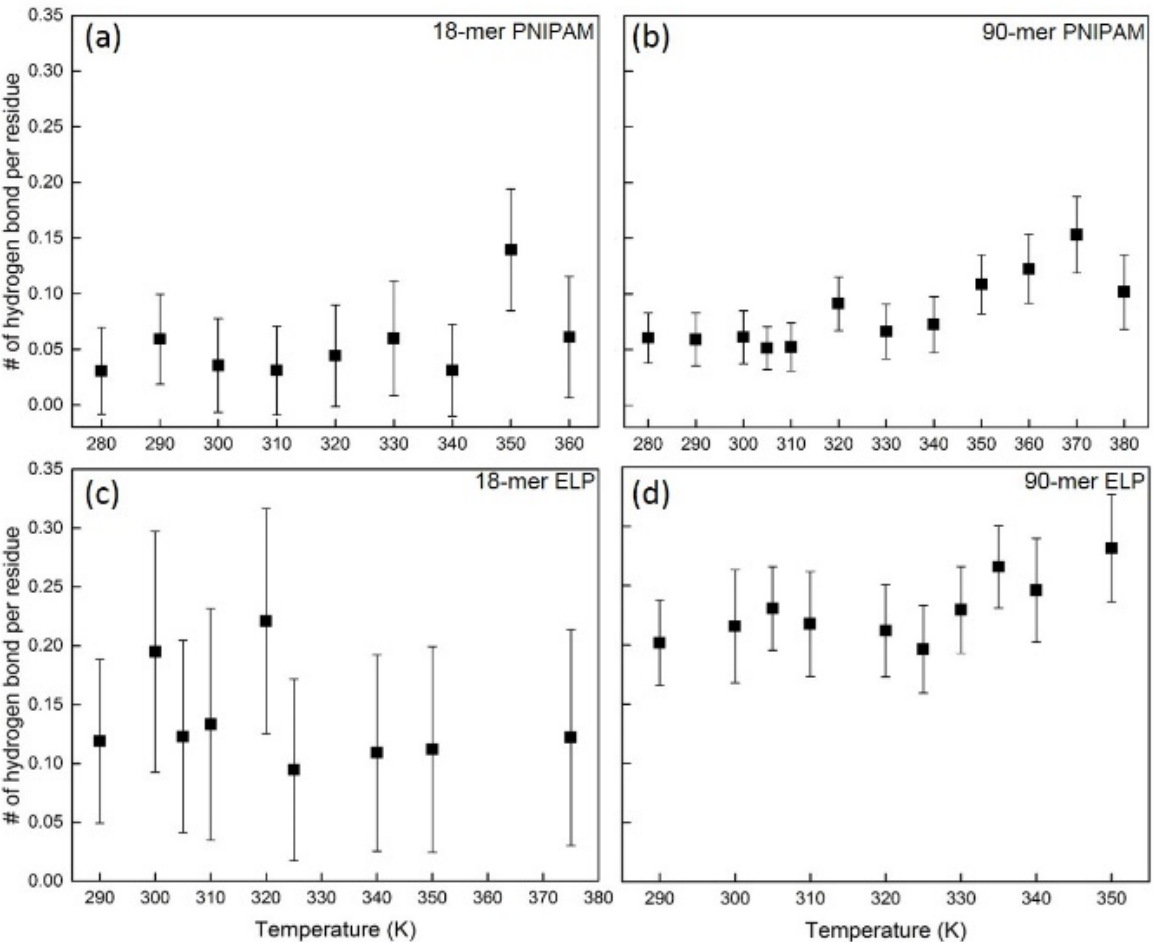
Figure 7. Hydrogen bonds between hydrophilic groups (C=O and >N–H) within polymer as a func- tion of temperature for ( a ) 18-mer PNIPAM and ( b ) 90-mer PNIPAM. Number of intra-peptide hydro- gen bonds per residues as a function of temperature for ( c ) 18-mer and ( d ) 90-mer ELP, GVG(VPGVG) 3 and (VPGVG) 18 , respectively.